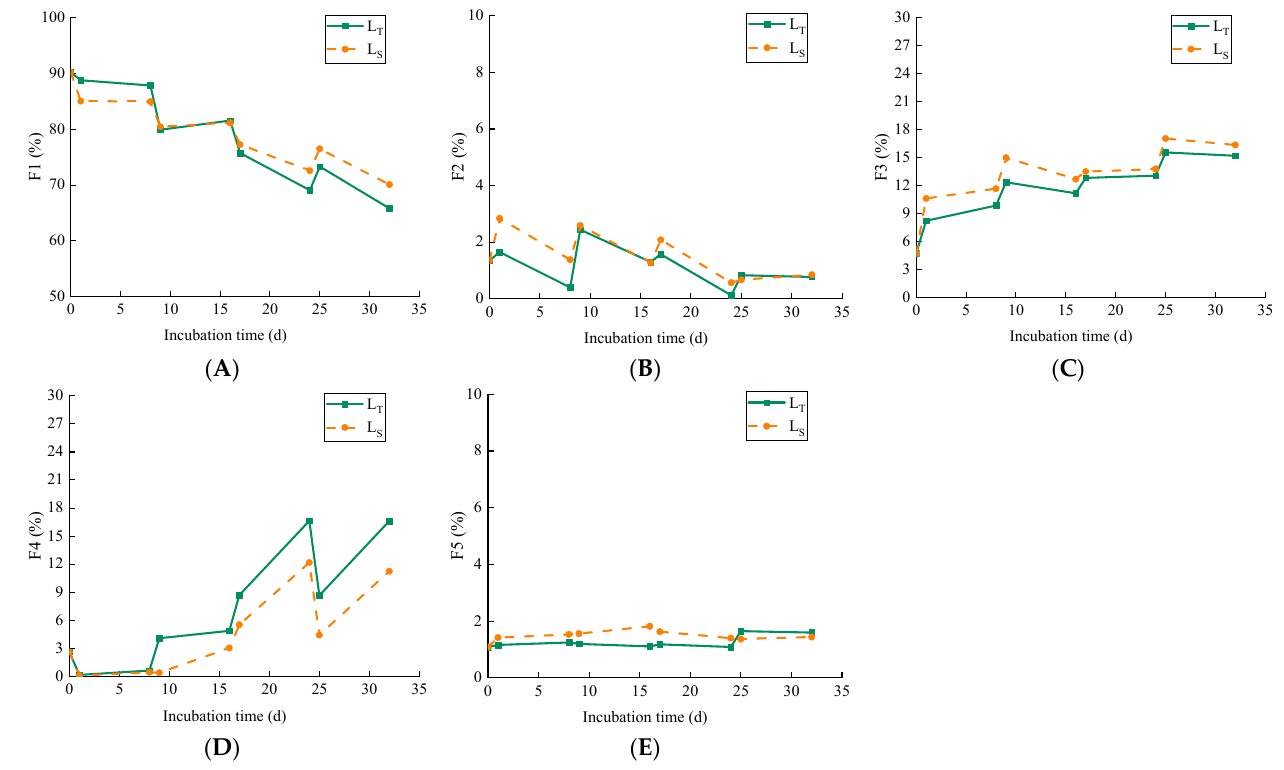
Figure 4. Changes of Cd fractions in the L T and the L S over time under intermittent irrigation (( A ) exchangeable Cd; ( B ) carbonates bound Cd; ( C ) Fe and Mn oxides bound Cd; ( D ) organic matter and secondary sulfide bound Cd; ( E ) residual